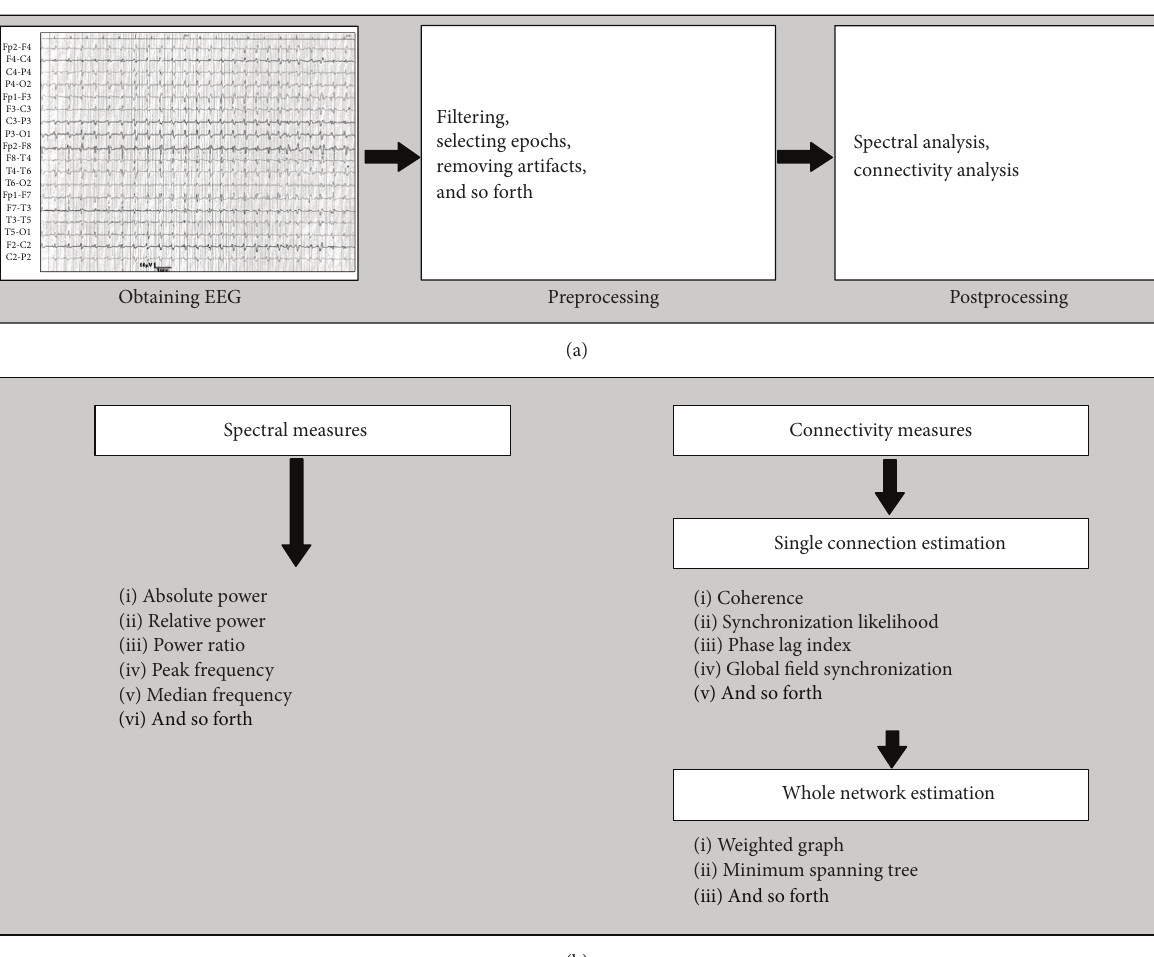
Figure 1: Outlines of the QEEG process. (a) Main steps of the processing; (b) spectral and functional connectivity